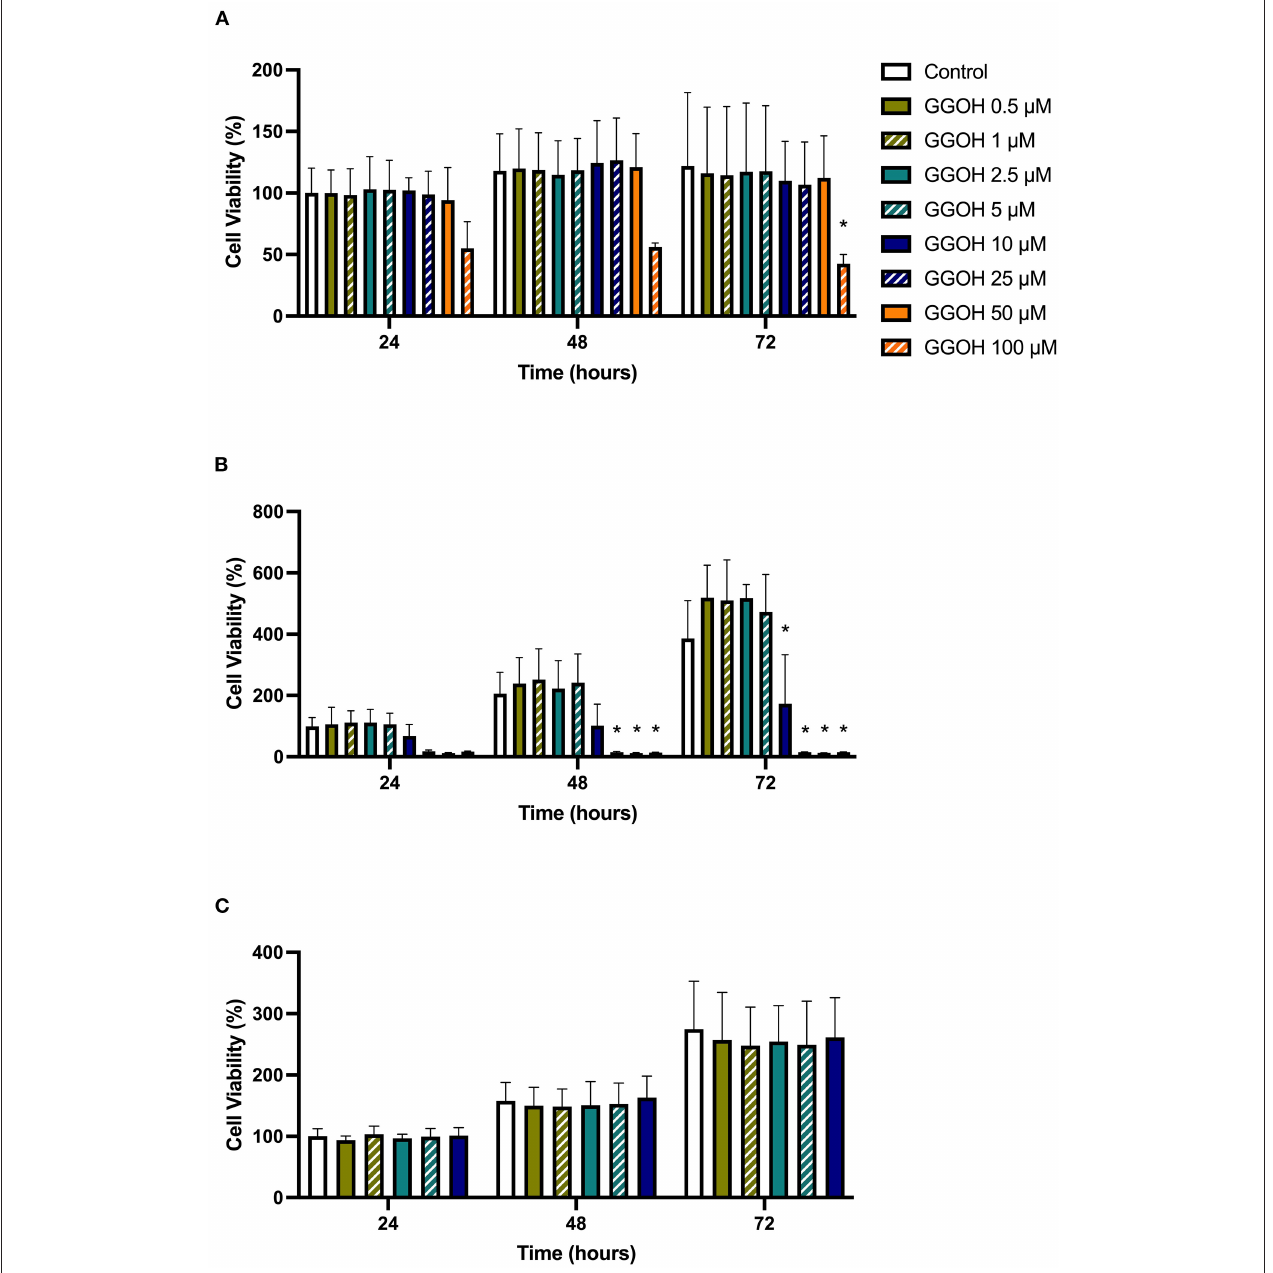
FIGURE 2 | The metabolic activities of (A) NOFs (B) OKF6/TERT-2 (C) NOKs after treated with different GGOH concentrations over 72h of treatment. All N = 3 except control and GGOH 10 µ M of (B) , N = 6. Mean + /- standard deviation (SD). Significance (*) was indicated when * p ≤ 0.05 in comparison to GGOH 0 µ M.